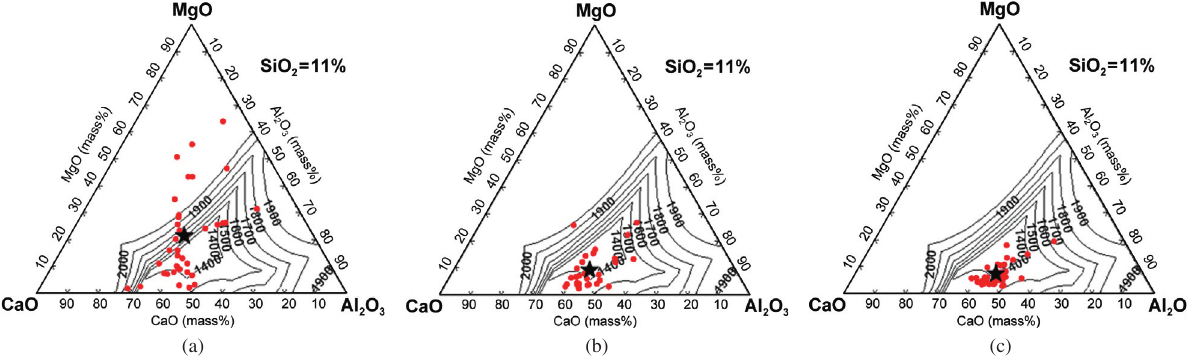
Figure 4 : Composition distribution of inclusions under different Al 2 O 3 slags. (a) Slag No. 4 (Al 2 O 3 : 21.22%); (b) slag No. 2 (Al 2 O 3 : 25%); (c) slag No. 5 (Al 2 O 3 : 30.04%).